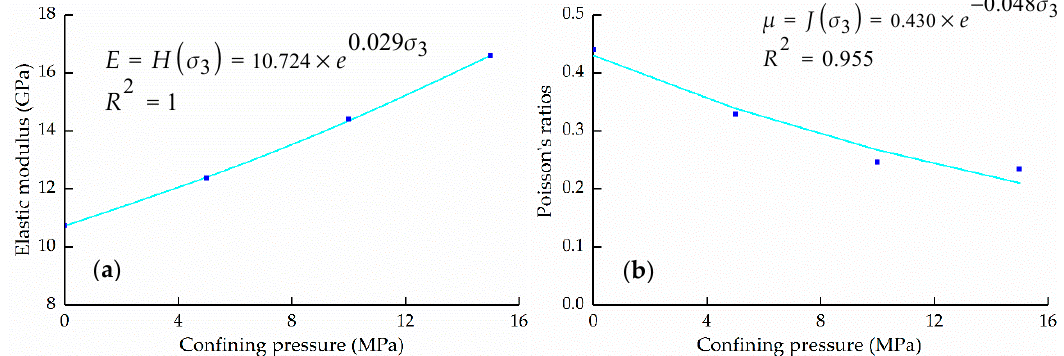
Figure 4. Regression curves of ( a ) cohesion force vs. plastic softening parameter and ( b ) internal friction angle vs. plastic softening parameter.